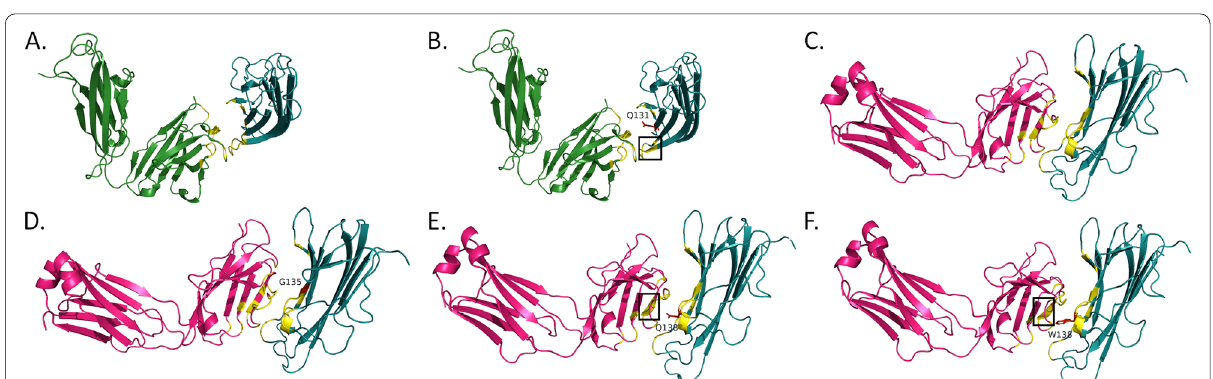
Fig. 4 Interactions between TNFA and certolizumab pegol. Interactions between TNFA and the heavy chain of certolizumab pegol in the wild-type ( A ) and TNFA R131Q variant ( B ) structures. Interactions between TNFA and the light chain of certolizumab pegol in the wild-type ( C ), TNFA E135G ( D ), TNFA R138Q ( E ), and TNFA R138W ( F ) variant structures. Forest green- heavy chain of certolizumab pegol; hot pink-, light chain of certolizumab pegol; deep teal- TNFA; yellow- interface; red- mutated residue. Regions with altered antigen-antibody interactions are denoted with black